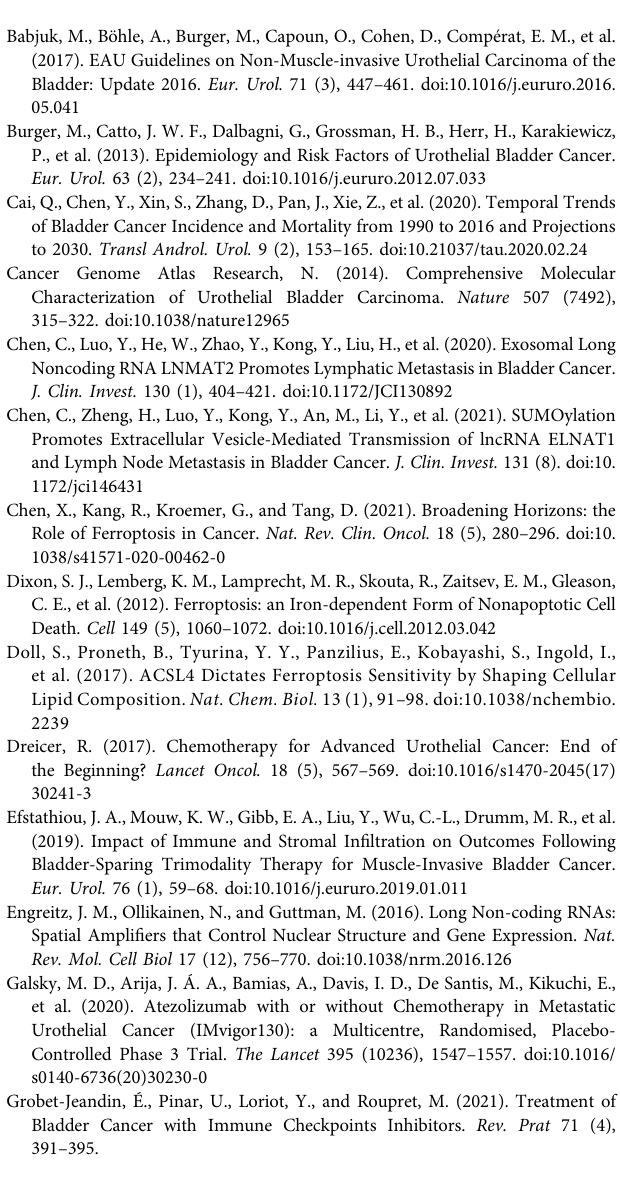
(C) ROC curve of prognostic indicators for bladder cancer. (D) Time-dependent ROC curve of the risk score. Supplementary Figure S6 | Analysis of m6A-related gene expression in two risk groups. Supplementary Figure S7 | The samples were grouped according to the abundance of immune cells, and the overall survival rate between grades was compared.MemoryBcells (A) ,M0macrophages (B) ,M2macrophages (C) ,resting mast cells (D) , neutrophils (E) , activated NK cells (F) , plasma cells (G) , activated CD4 + memory T cells (H) , and CD8 + T cells (I) . Supplementary Figure S8 | The different immune function scores of the samples were calculated, and the overall survival of the high rating group and the low rating group were compared. APC co-inhibition (A) , checkpoint (B) , cytolytic activity (C) , HLA (D) , in fl ammation-promoting (E) , MHC class I (F) , T-cell co-inhibition (G) , T-cell co-stimulation (H) , and type I IFN response (I)